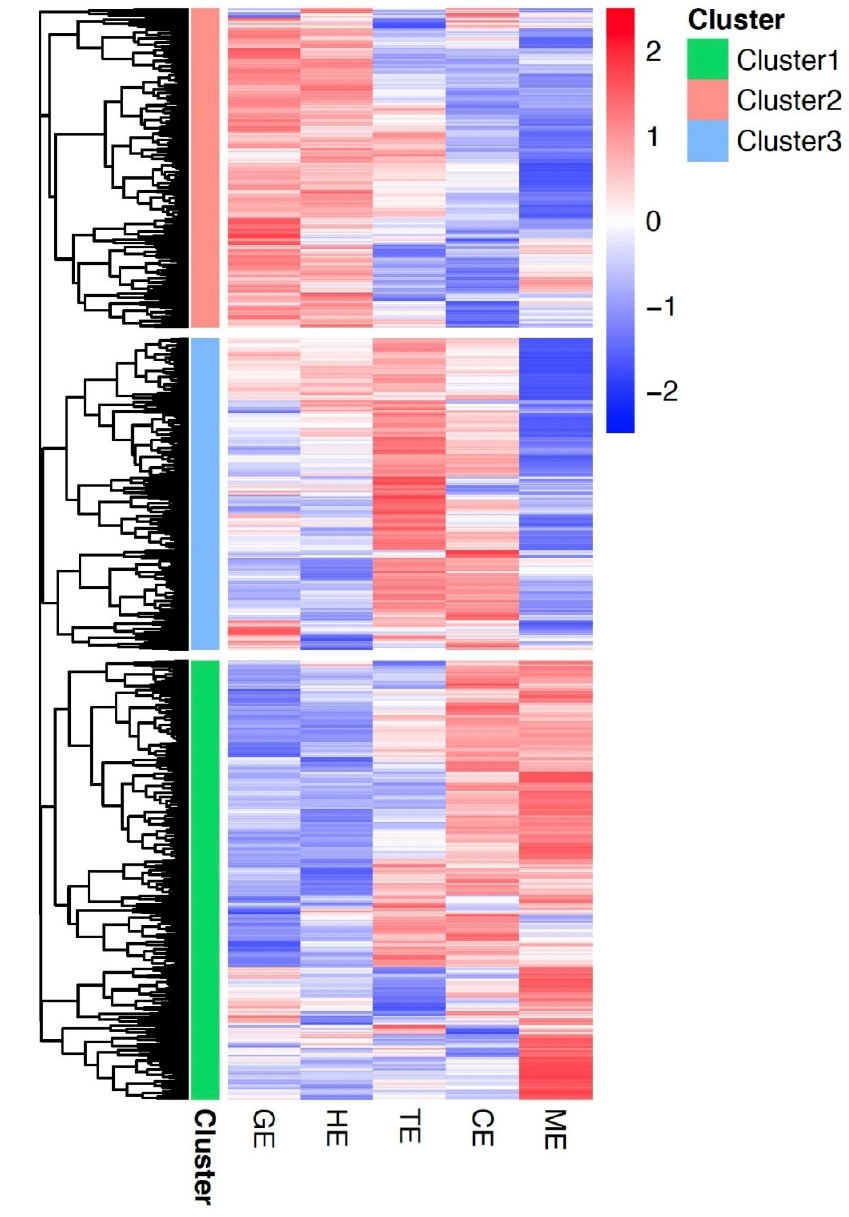
Figure 5. Storage-related lipid genes and carbohydrate gene-expression patterns during embryonic developmental process in flax. Heatmaps of clustered storage-related lipid and carbohydrate genes with similar expression patterns were generated during embryogenesis. Three clusters for each tissue were identified, shown with different colors as defined in the right inset. Z-score transformations of expression were performed for each gene across all developmental stages. Expression levels were indicated by color scheme, from red (high) to blue (low) in corresponding stages, as defined in the inset. Genes in each species or each cluster are associated with a color on the left of each heatmap. Three clusters represent three categories highly expressed in different adjacent stages.